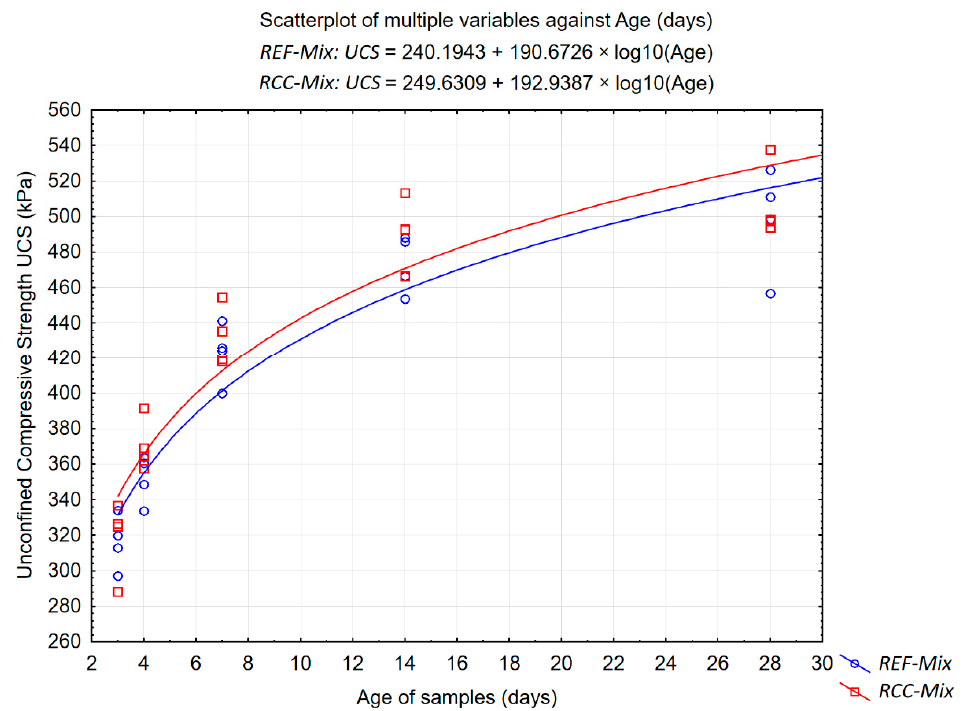
Figure 13. Results of the unconfined compressive strength tests on the samples from the REF-Mix and RCC-Mix mixtures for the age of samples (age); error bars show standard deviations; increase of unconfined compressive strength shown as a percentage.